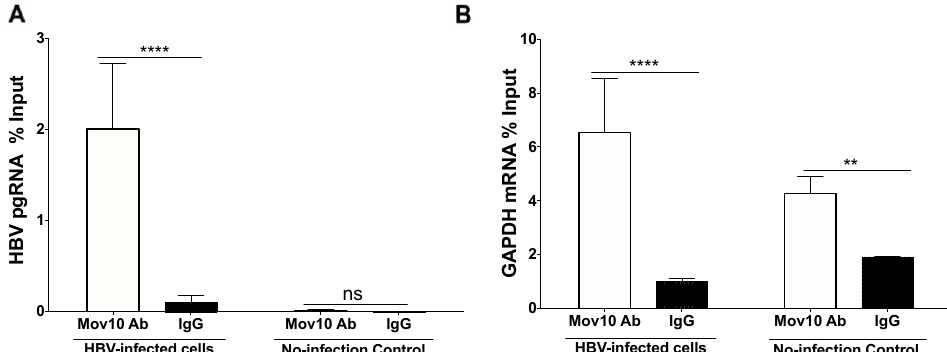
Figure 6. HBV pre-genomic RNA co-immunoprecipitated with MOV10. ( A ) HepG2-NTCP clone 7 cells were infected with HBV and harvested after five days. Immunoprecipitation was performed with an antibody against human MOV10 in the HBV-infected cells and in the non-infected control cells. SYBR Green-based RT-qPCR was done using primers against HBV pre-genomic RNA. ( B ) Human GAPDH mRNA co-immunoprecipitated with MOV10. SYBR Green-based RT-qPCR was done using primers against human GAPDH mRNA. ( n = two independent experiments, ** p = 0.0015, **** p < 0.0001, two-way ANOVA Sidak’s multiple comparisons